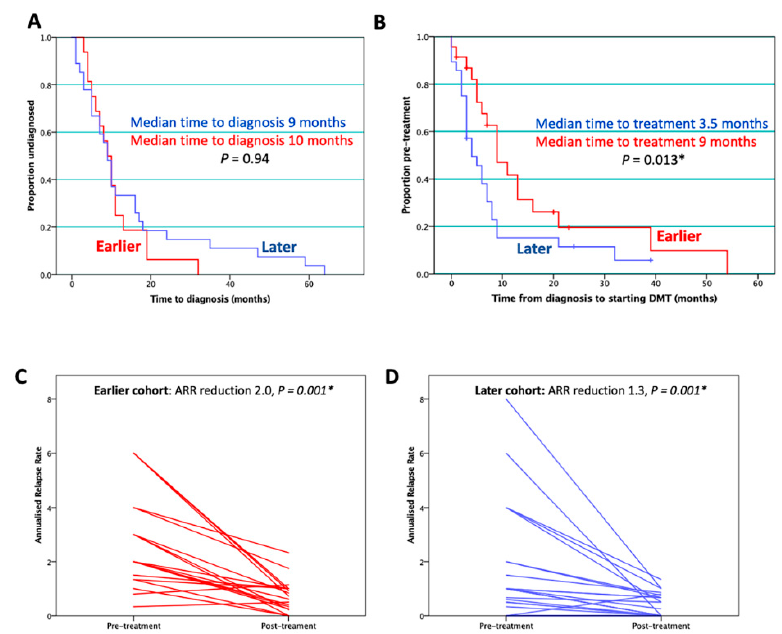
Figure 1. Effective treatment of POMS patients. ( A ) Time to diagnosis did not significantly differ between cohorts. ( B ) Time from diagnosis to first disease-modifying treatment was significantly shorter in the later cohort. Markers show duration of follow up for patients never started on DMT. ( C , D ) Annualised relapse rates (ARRs) decreased significantly in both cohorts after treatment initiation.